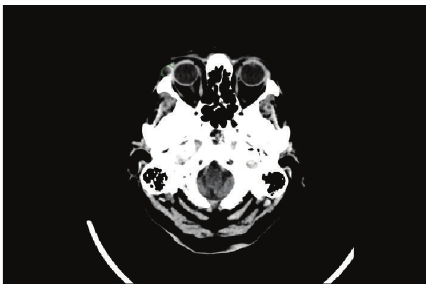
Figure 1: Axial view of CT scan showing a right supraorbital mass prior to surgery.